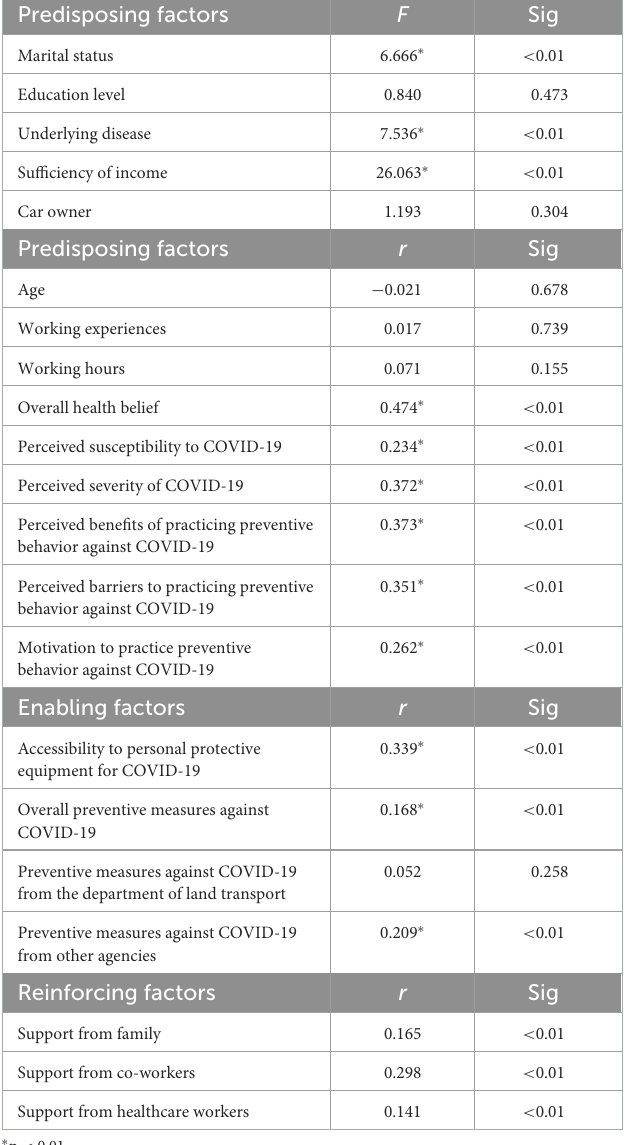
TABLE 6 Correlations coefficient among predisposing factors, enabling factors, and reinforcing factors and COVID-19 preventive behaviors among taxi drivers in Bangkok ( N = 401).